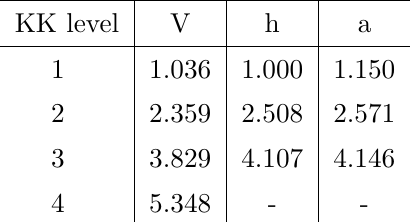
for the BM2 point 1